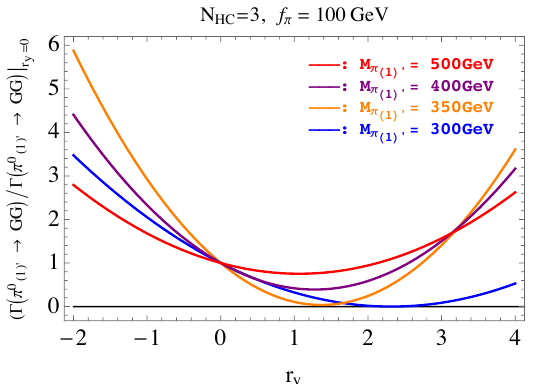
! GG ) = (cid:0)( (cid:25) 0 ! GG ) j r under the four di(cid:11)erent (1) 0 (1) 0 y =0